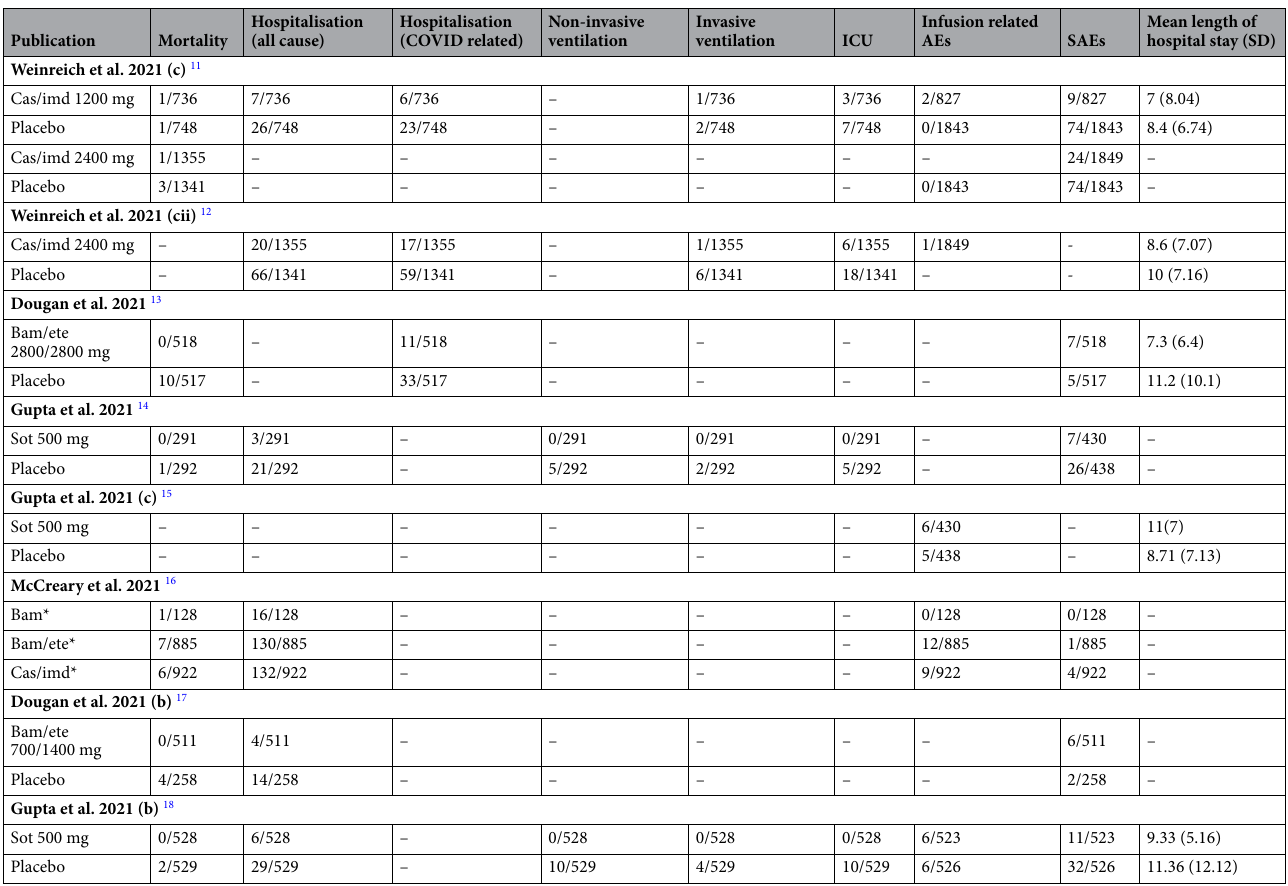
Table 2. Outcome data extracted from articles. Bam, bamlanivimab; Bam/ete, bamlanivimab/etesevimab; Sot, sotrovimab; Cas/imd, casirivimab/imdevimab; ICU, intensive care unit; AE, adverse event; SAE,